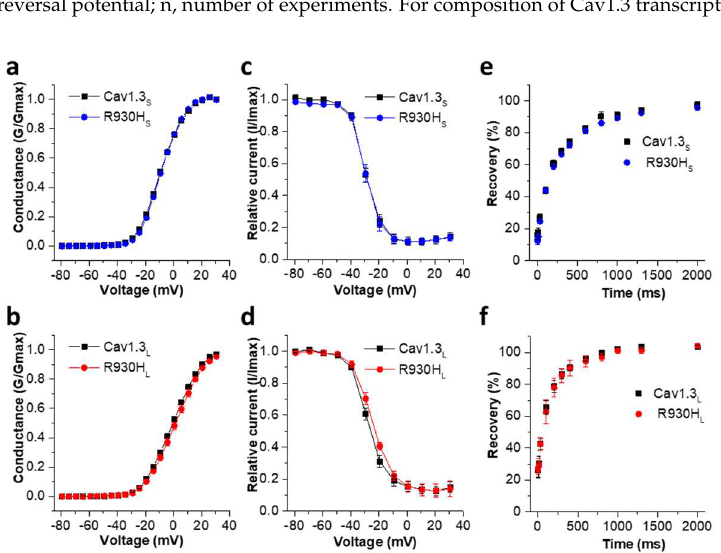
Figure 4. R930H does not alter activation and inactivation parameters of Cav1.3 S and Cav1.3 L . ( a ) Voltage-dependence of activation of the wild-type and mutant Cav1.3 S and ( b ) Cav1.3 L variants. ( c )